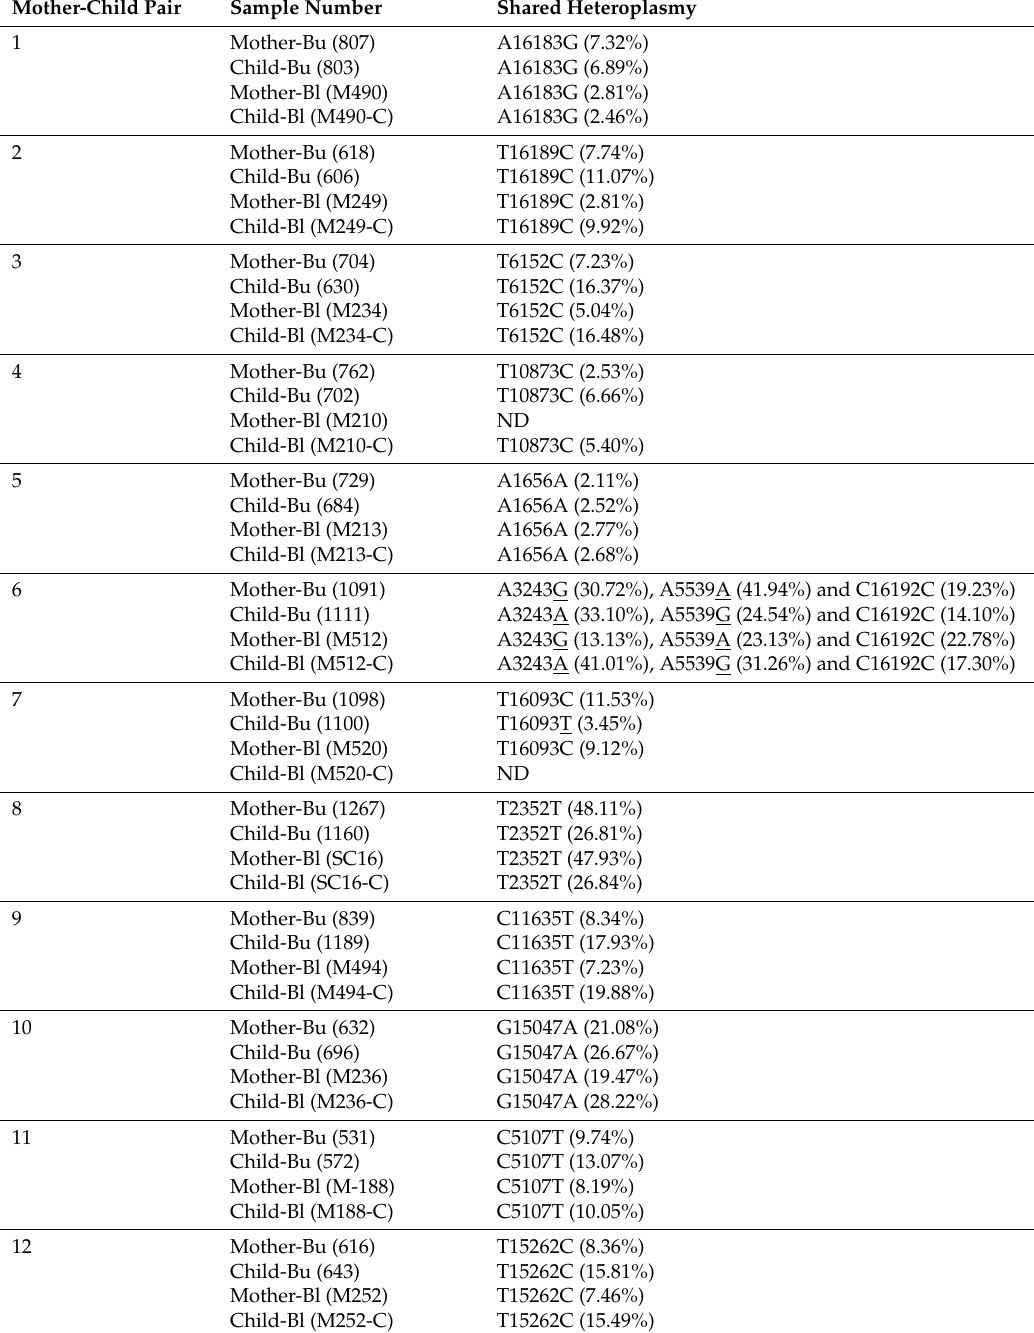
Table 1. Shared heteroplasmy for 12 of the 39 mother-child pairs. Frequency of heteroplasmy at each nucleotide position (np) in percentage (%), with the minor variant annotated as the letter after the np; i.e., A1656A (2.11%) is heteroplasmy at np 1656, with the first A as the reference sequence and the second A as the minor variant at 2.11% of the reads. Underlined letters following the np of heteroplasmy indicate a primary haplotype change between the mother and child. In two instances, heteroplasmy was not detected (ND) in a